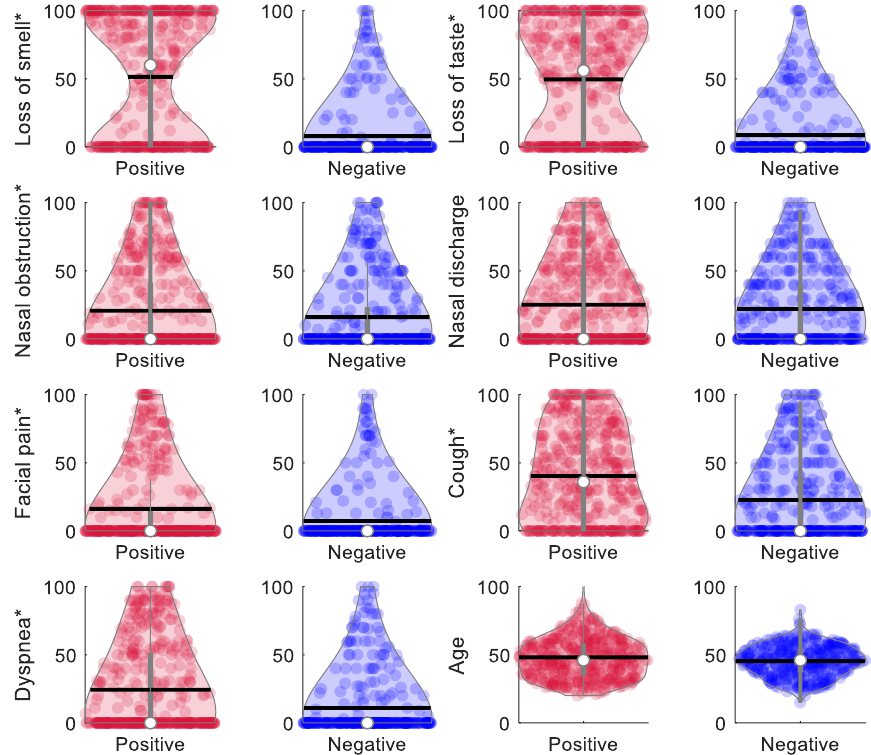
Figure 2. Violin plots showing the distribution of self-reported VAS scores for symptom intensity. The white dots depict the median value and the vertical gray lines the interquartile range (25th and 75th quantiles). Horizontal black lines represent the mean value. Symptoms accompanied with an asterisk (*) showed significant differences in the Student’s t -test between positive and negative groups: loss of smell, loss of taste, facial pain, cough, dyspnea ( p < 0.0001), and nasal obstruction ( p = 0.0311). Nasal discharge ( p = 0.1481) and age ( p = 0.0628) were not significantly different between groups.